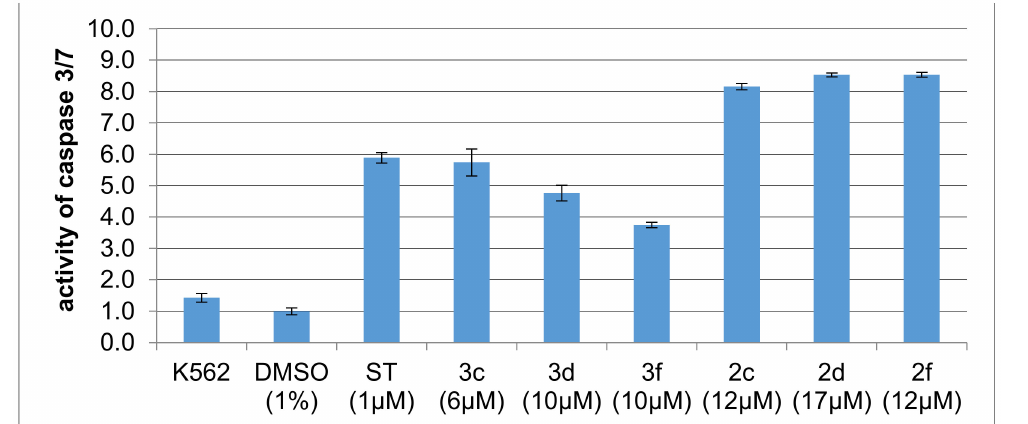
Figure 2. Activity of caspase 3/7 in K562 cells treated with the test dicarboximides or staurosporine for 18 h. Abbreviations: K562—untreated cells; DMSO—K562 cells treated with 1% DMSO; ST—staurosporine. The activity of caspase 3/7 in cells exposed to 1% DMSO was normalized to 1.0. Mean values ± SD are